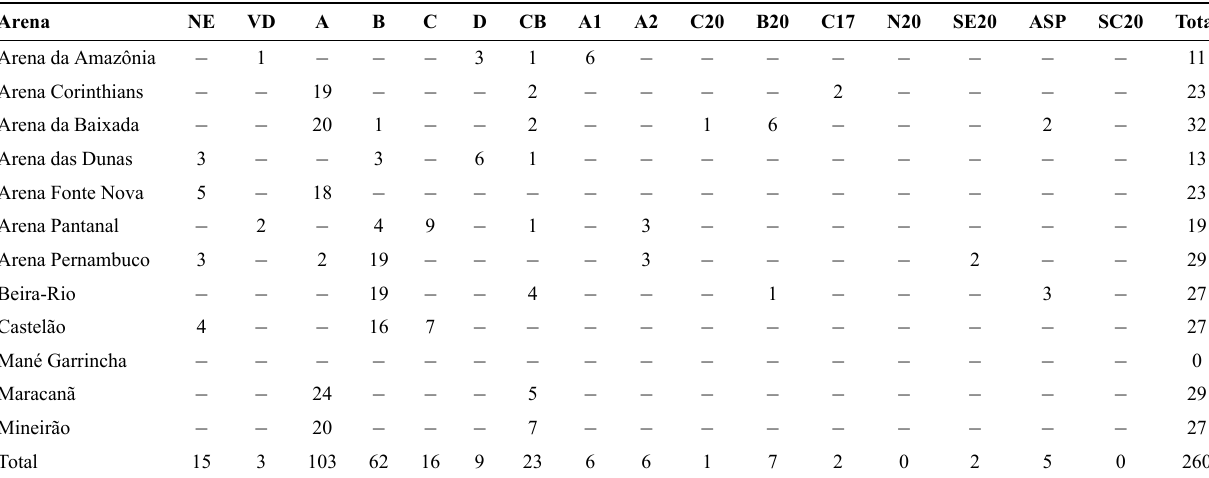
Table 5 - Arena usage in the 2017 season.